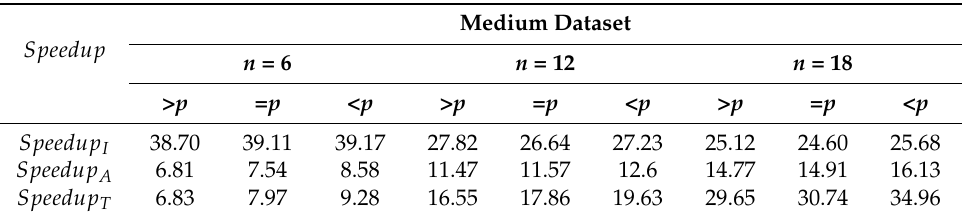
Table 4. Speedup obtained with a single card on Shelob (medium dataset).